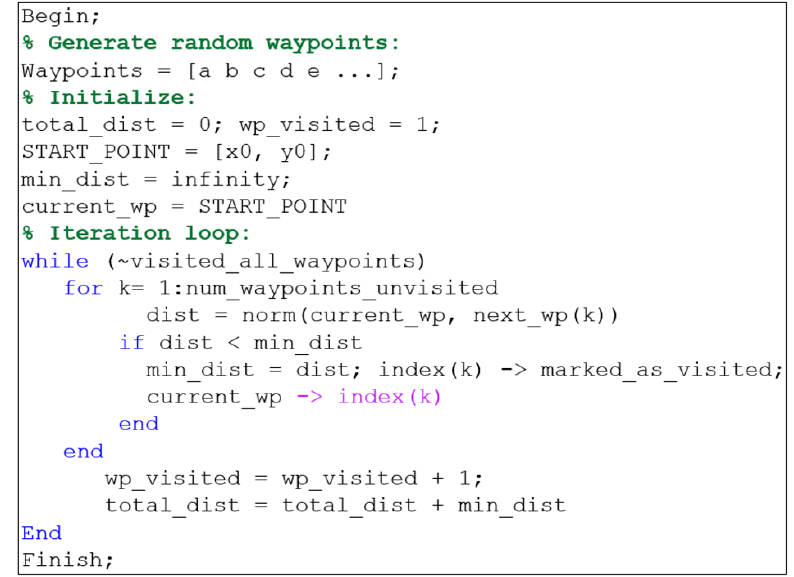
Figure 6. The Genetic Algorithm pseudo code.